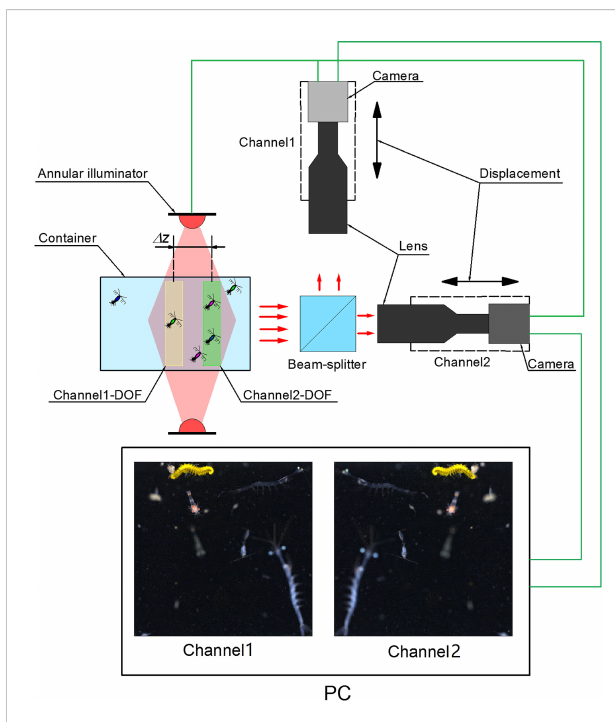
FIGURE 2 Setup of the dual-channel dark fi eld imaging apparatus for defocused- focused live plankton dark fi eld image pair